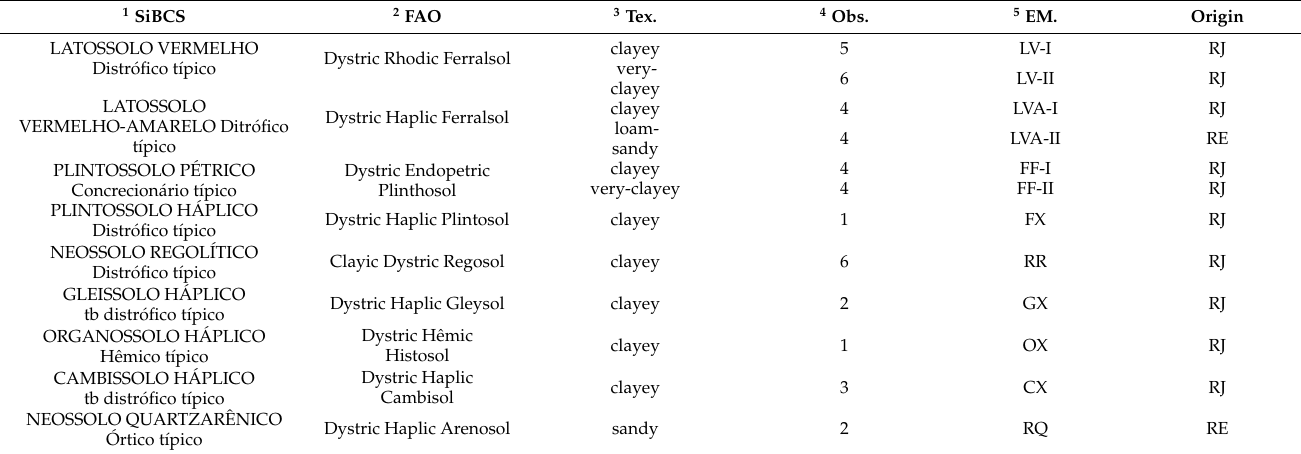
Table 1. Brazilian and worldwide soil classification system of the study